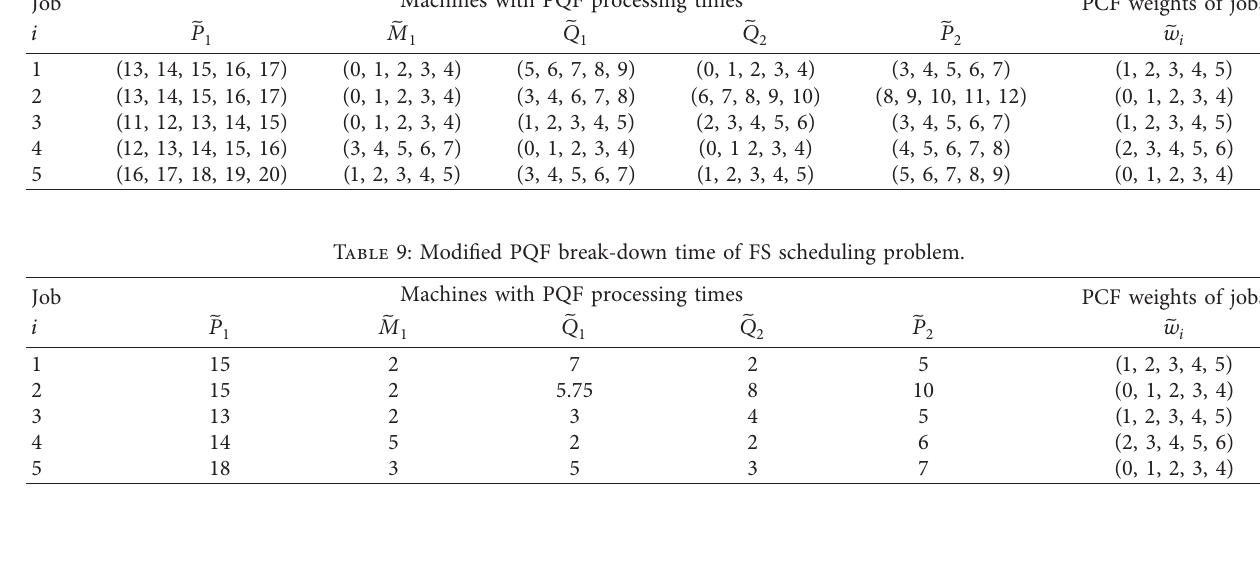
Table 10: PQF elapsed time of the scheduling